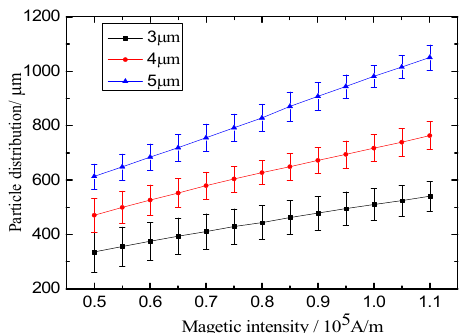
Figure 7. E ff ect of magnetic fields on the particles’ distributions. Figure 7. Effect of magnetic fields on the particles’ distributions.